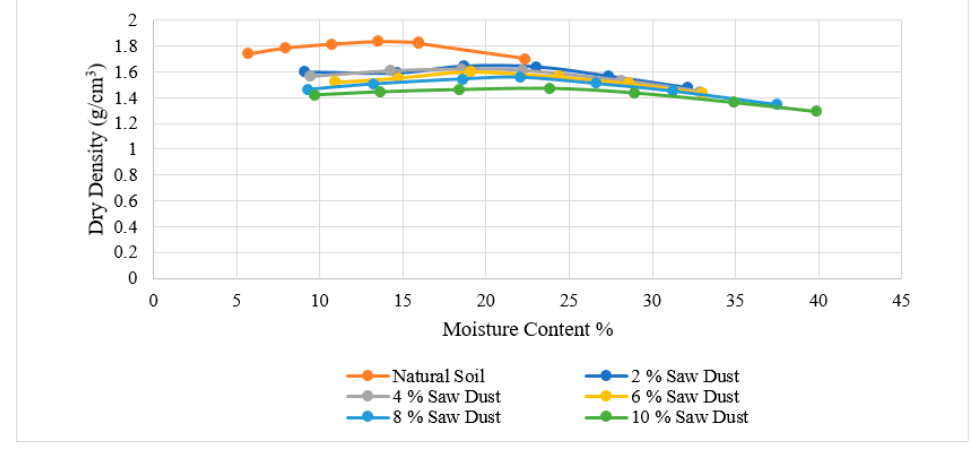
Figure 8. Rice husk ash Proctor results.